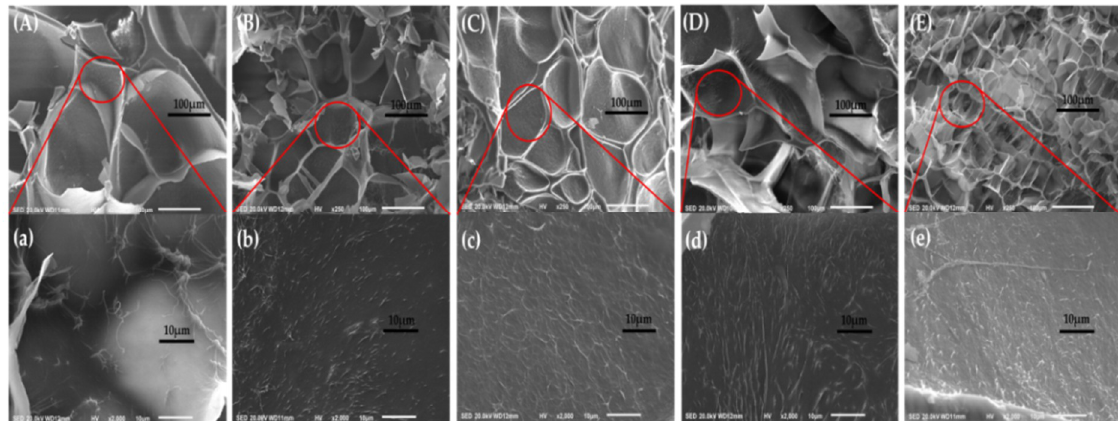
Figure 11. SEM images of composite hydrogels with different ASF content: ( A , a ) A1N9, ( B , b ) A2N8, ( C , c ) A3N7, ( D , d ) A4N6, ( E , e ) A5N5.